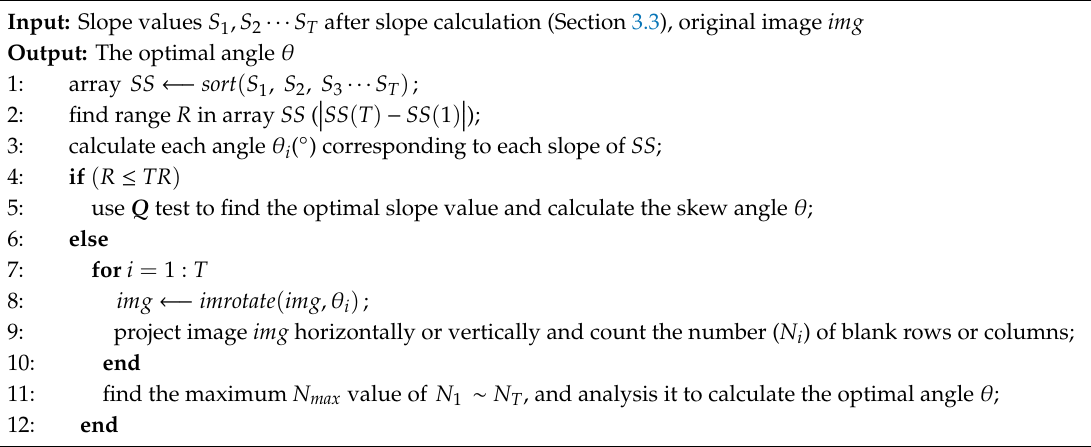
Algorithm 1. A procedure to find the optimal skew angle value.